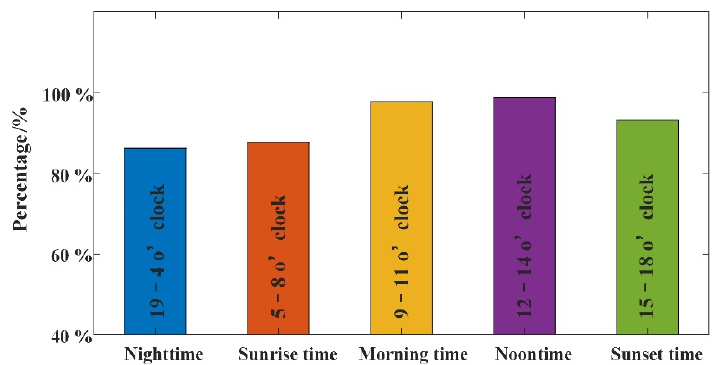
Figure 8. The percentage of high ‐ quality transmission in the Taiwan Strait.